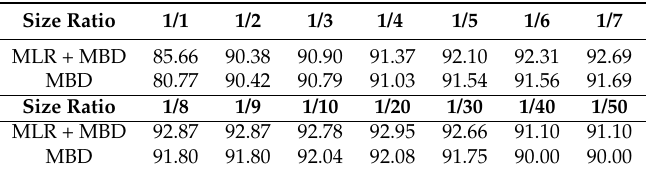
Table 12. Minority size analysis for MBD on